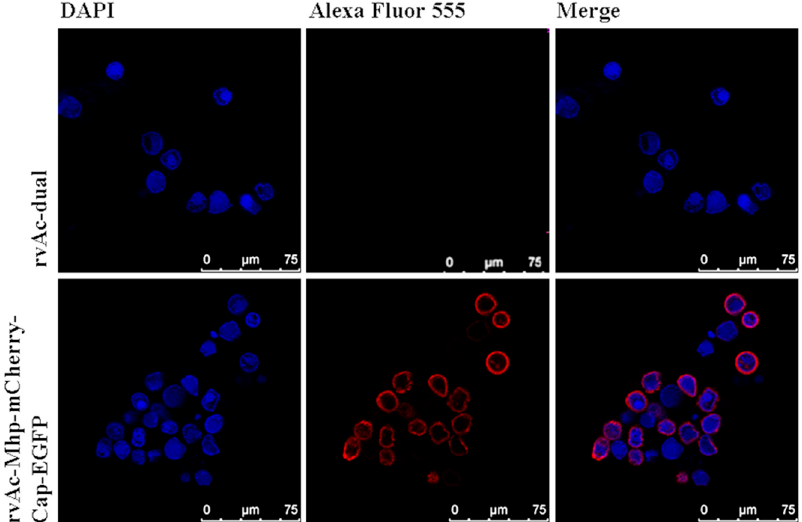
Figure 4. Confocal microscopy analysis showed the P97R1P46P42 and Cap proteins anchored on the plasma membrane of infected Sf9 cells.